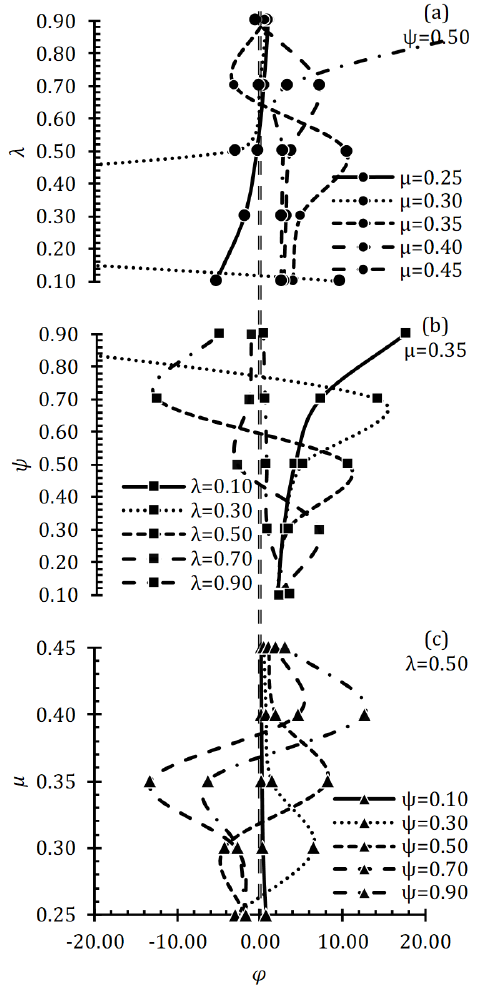
Figure 5. Effect of λ , ψ and µ on ϕ